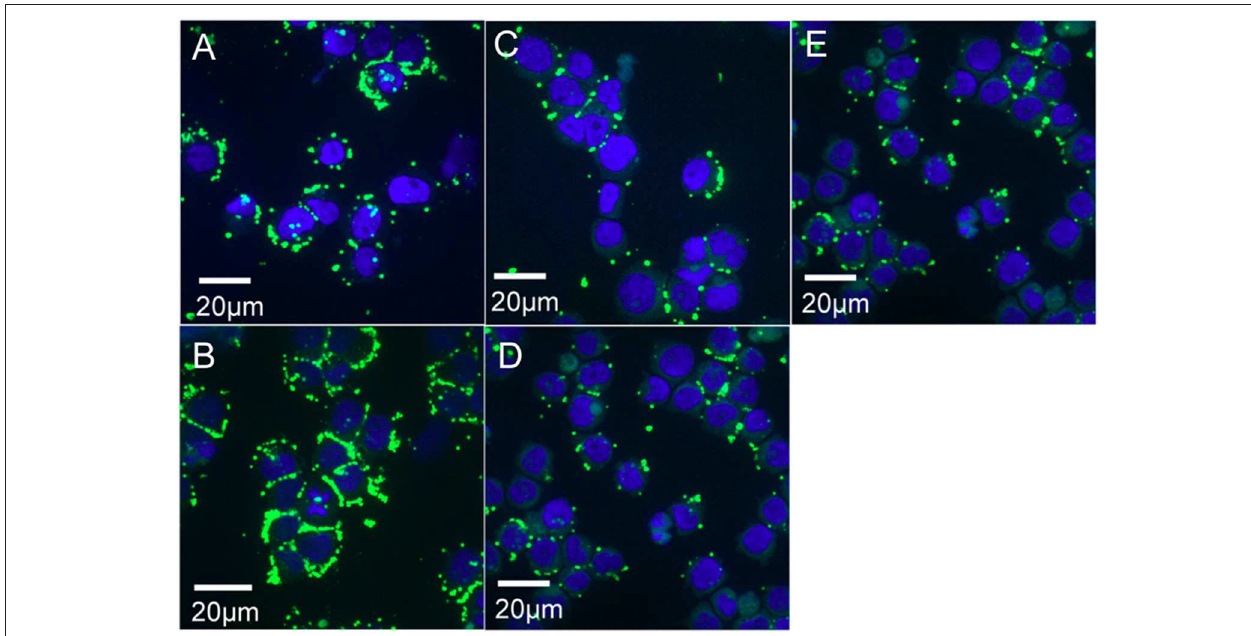
FIGURE 1 | Confocal microscopy images of A. phagocytophilum (Ap) binding/entering HL-60 and ISE6 cells. Cell nuclei are stained blue with DAPI, bacteria green by immunofluorescence (primary antibody: dog anti-Ap serum; secondary antibody: goat anti-dog IgG-FITC). (A) Sample 1 (Ap incubated with HL-60 for 2h; (B) Sample 2 (Ap incubated with HL-60 for 4h); (C) Sample 3 (Ap incubated with ISE6 for 2h; (D) Sample 4 (Ap incubated with ISE6 for 4h); and (E) Sample 5 (HL-60-grown bacteria incubated with ISE6 cells for 2